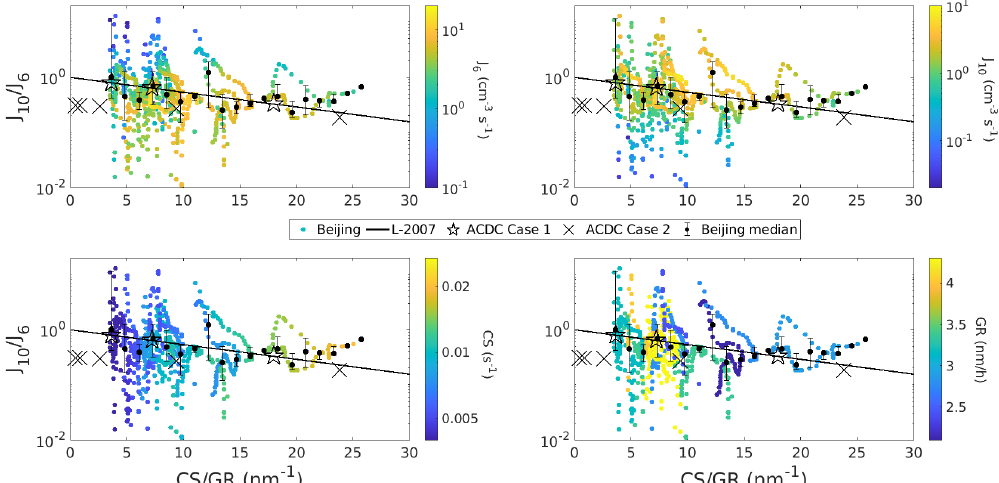
Figure 9. Survival probability from 6 to 10nm ( J 10 /J 6 ) as a function of the ratio of condensation sink and growth rate (CS / GR). Survival probabilities from Beijing, China, ACDC model simulations, and the predictions based on the theoretical formulation by Lehtinen et al. (2007) (L-2007) are included. ACDC Case 1 refers to simulations with no collisions between clusters, while in Case 2 simulations, cluster–cluster collisions also occurred. Median values for observed J 10 /J 6 have been determined based on bin division of horizontal values and the quartiles are shown as the error bars. The top left figure is shaded with the J 6 while the top right, bottom left, and bottom right are shaded with the J 10 , the CS, and the GR,